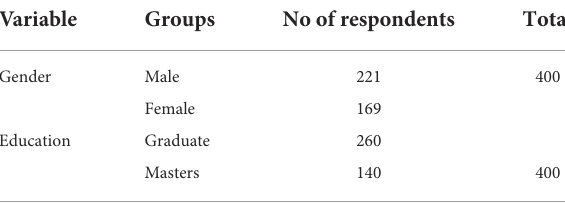
TABLE 1 Demographic